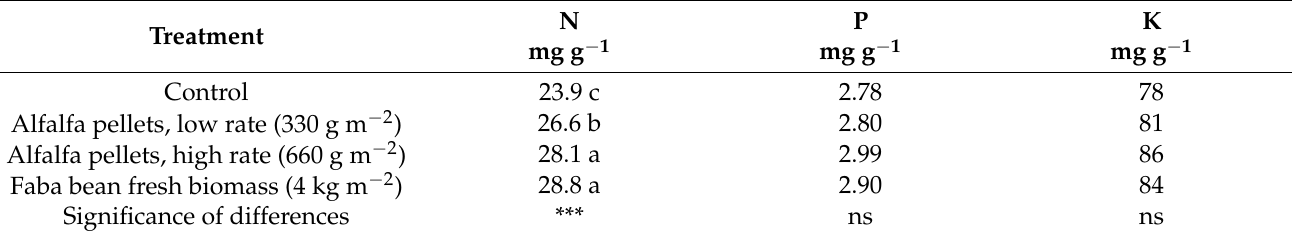
Table 3. The impact of different organic fertilization treatments on leaf N, P, and K dry matter concentrations in organic greenhouse